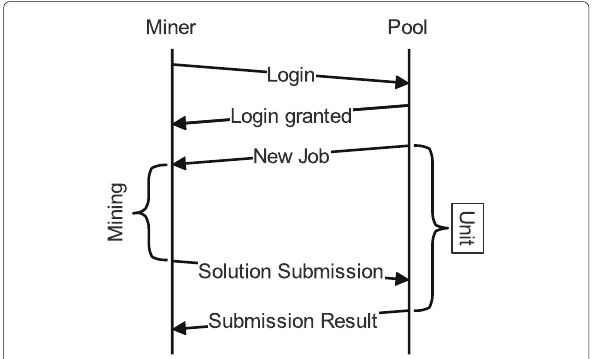
Fig. 1 Typical stratum mining workflow